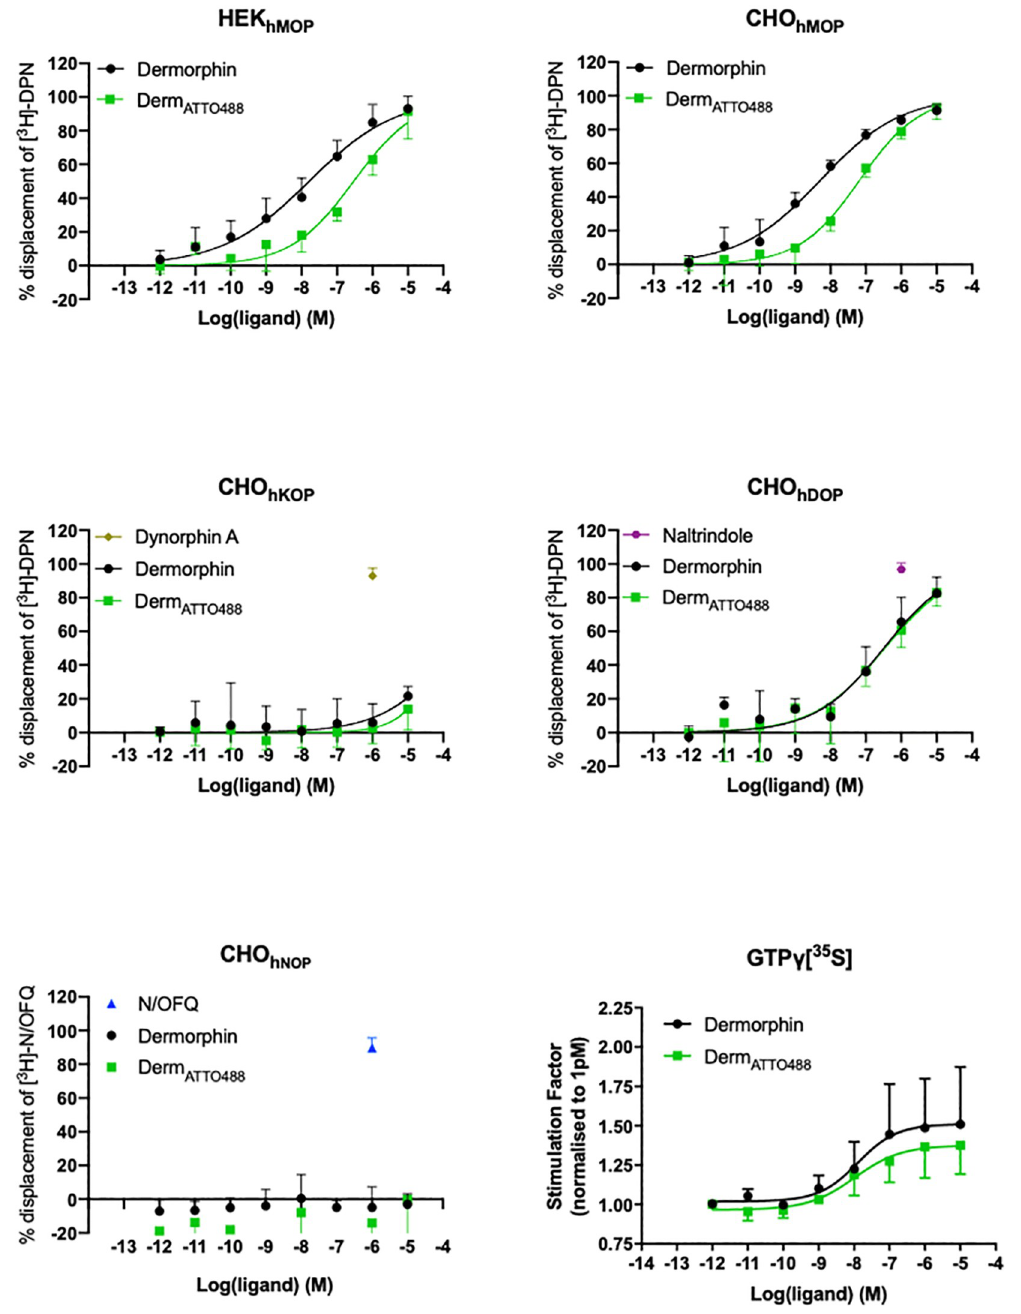
Fig 2. [ 3 H]-DPN displacement assay and GTP γ [ 35 S] activation assay. Displacement of [ 3 H]-DPN by Dermorphin, Derm ATTO488 , N/OFQ, Dynorphin A and Naltrindole in (A) HEK hMOP , (B) CHO hMOP , (C) CHO hKOP , (D) CHO hDOP and (E) CHO hNOP . Data are presented as mean (SEM) of n = 10 experiments for the HEK cells and n = 6 for CHO cell lines. pK i values are shown in Table 1. Ligand stimulated GTP γ [ 35 S] binding by Dermorphin and Derm ATTO488 at CHO hMOP (F). Data are presented as mean ( ± SEM) of n = 4 experiments. pEC 50 and E max values are shown in Table 2.